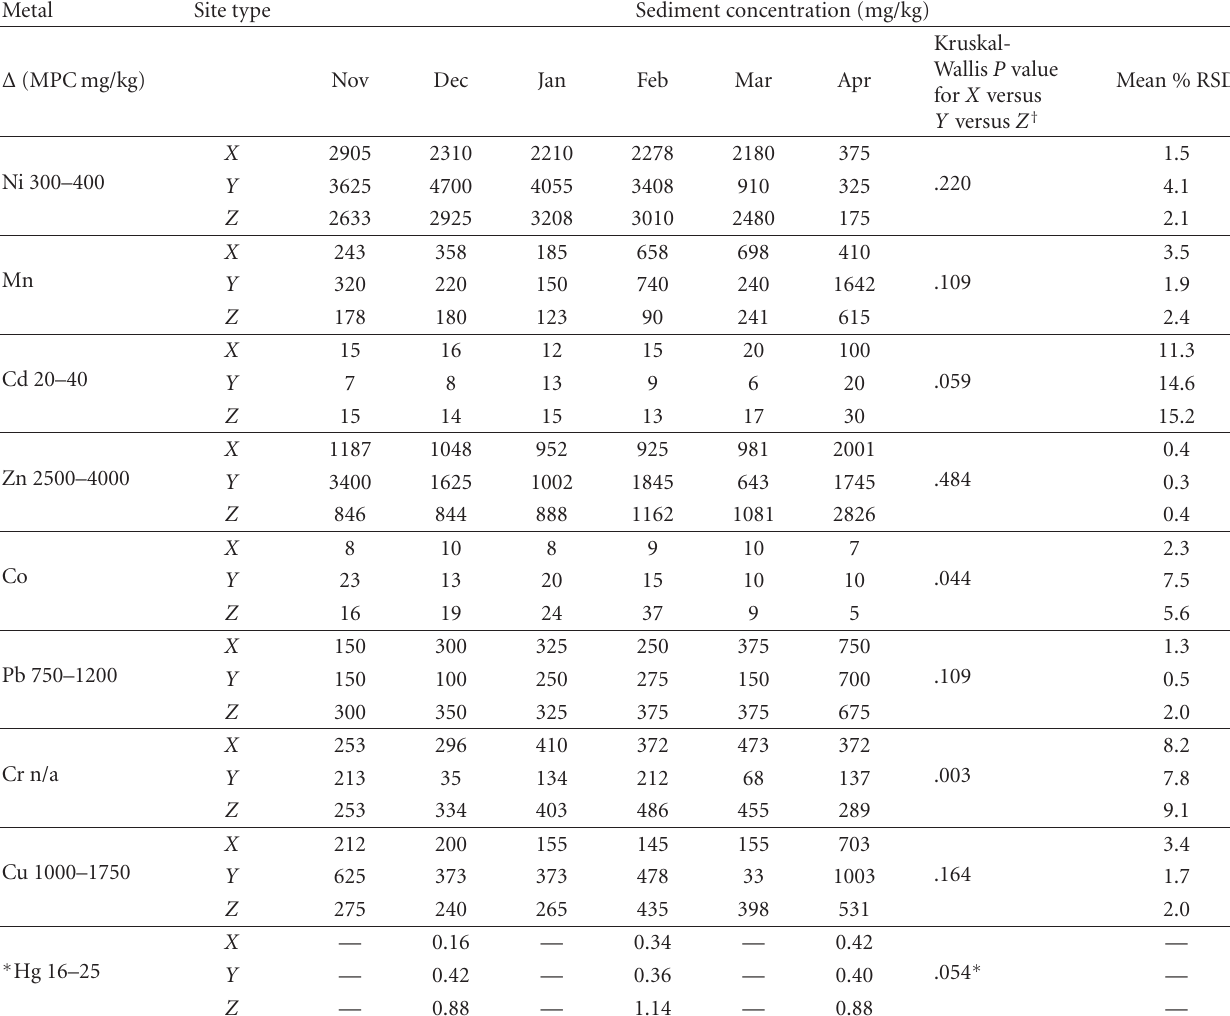
Table 10: Concentrations of metals found in sludge (mg/kg) for each treatment type.